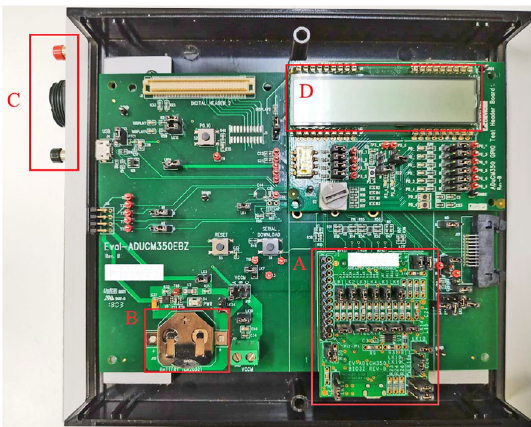
Figure 2. Prototype board of the insulin meter: motherboard ADuCM350 Vers.A with ( A ) daughterboard BIO3Z for 4-wire bioimpedance measurement, ( B ) battery, ( C ) ON and Reset buttons, and ( D )